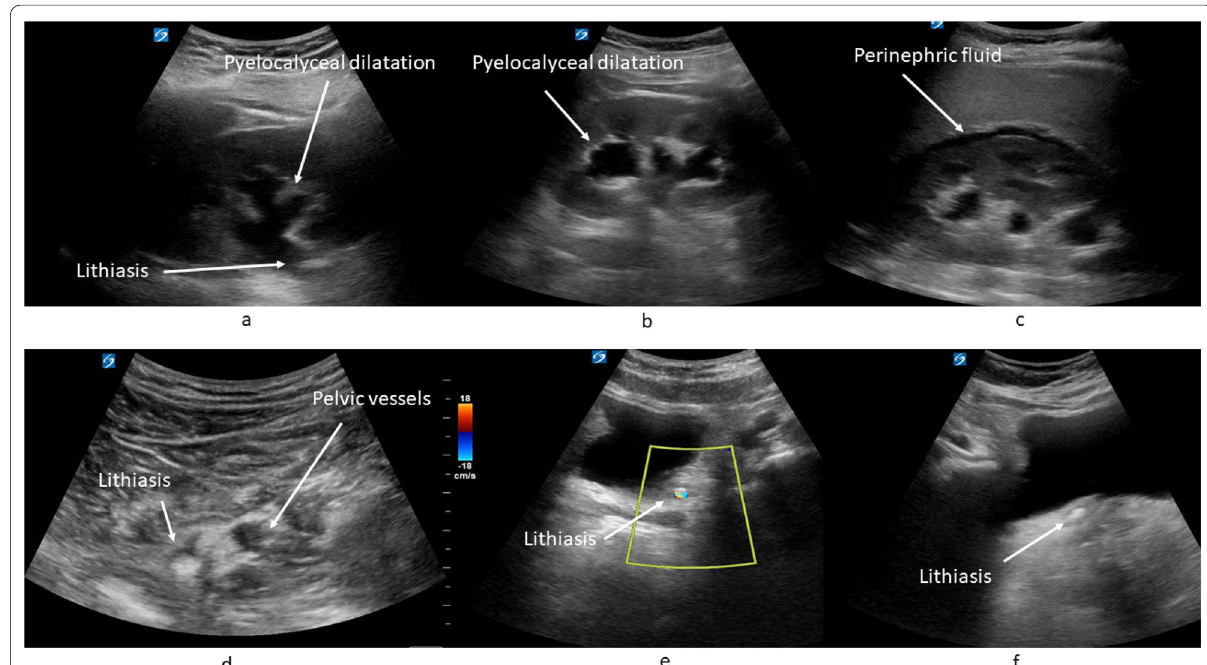
Fig. 2 Ultrasound images: a pyelocalyceal dilatation and proximal lithiasis, b pyelocalyceal dilatation, c perinephric fluid, d pelvic lithiasis, e bladder lithiasis and twinkle artifact in color doppler; and f bladder